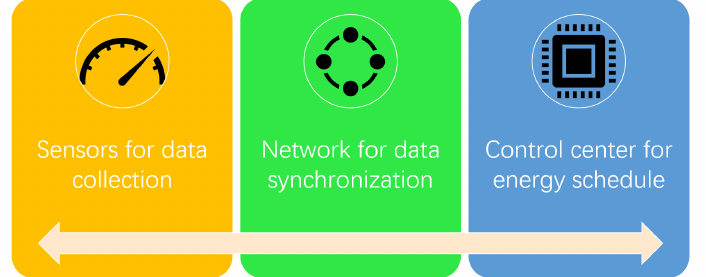
Figure 8. The workflow of the smart sustainability control structure